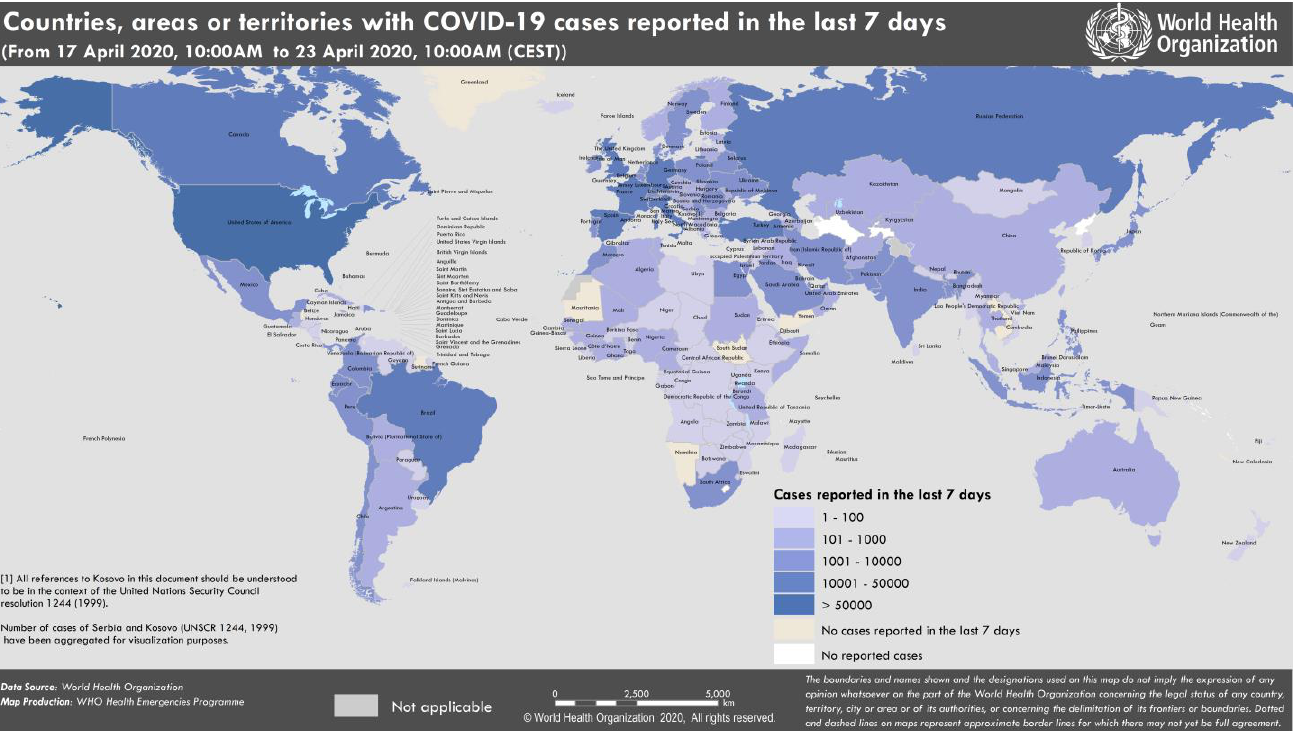
Figure 1. Countries, territories or areas with reported confirmed cases of COVID-19, 23 April